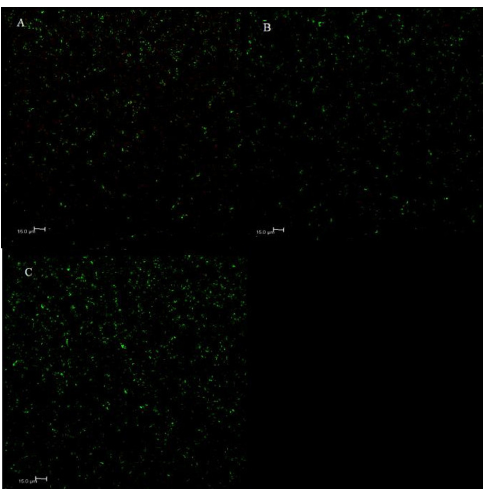
Fig 7. Representative images of the bactericidal effect of (A) bare, (B) positively charged and (C) negatively charged SPIONs on the S . mutans biofilm for a SPION concentration of 2 μ g mL -1 . Images for exposures to 1 μ g mL -1 and 3 μ g mL -1 can be found in S2 and S3 Figs. For each image, green coloration indicates live cells while red coloration indicates dead cells.